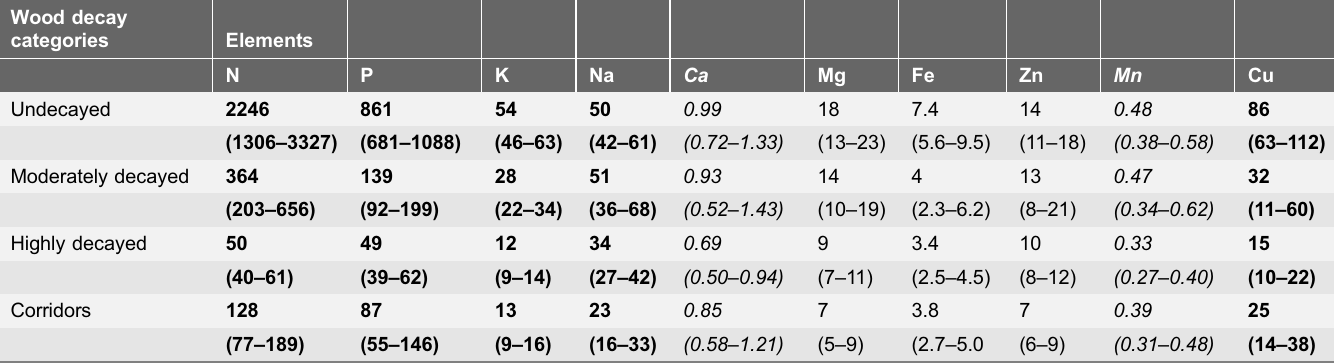
Table 2. Trophic stoichiometric ratios ( TSR 5 (C:x) wood /(C:x) beetle ); averages (lower bound – upper bound) of the bootstrapped distributions. Wood decay